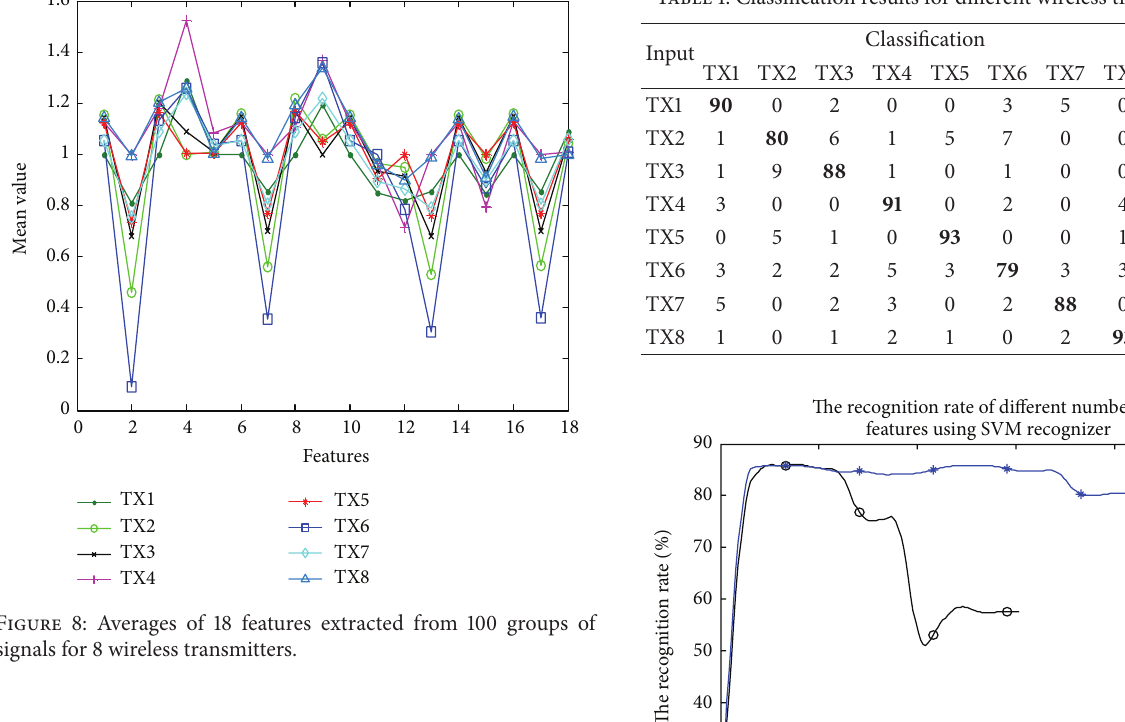
Table 1: Classification results for different wireless transmitters.